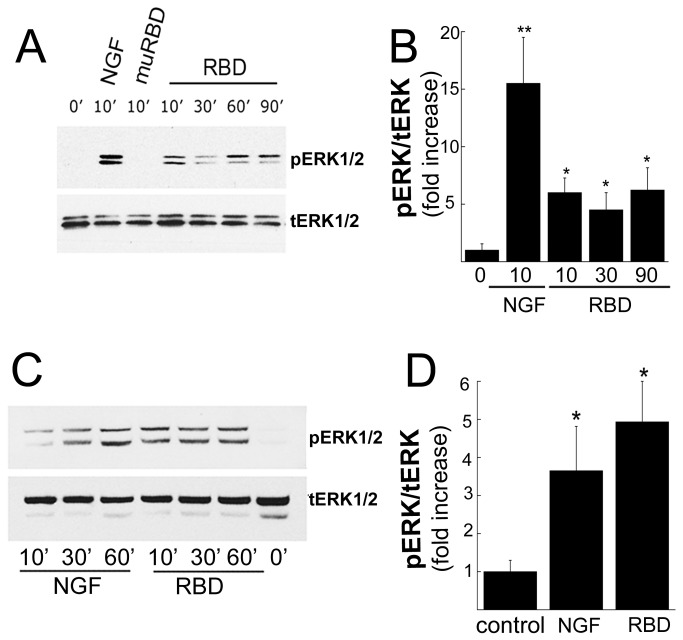
RBD induces LRP1-dependent and sustained ERK1/2 signaling in sensory neurons.
A, Immunoblot analysis of ERK1/2 after treatment with RBD, muRBD, NGF or vehicle for 0-90 min in PC12 cells. B, Quantification of ERK1/2 by densitometry (n=3-6/group). Total ERK1/2 was used as a loading control (**p<0.01; *p<0.05). C, Immunoblot analysis of ERK1/2 after RBD, NGF or vehicle treatment for 0-60 min in primary embryonic sensory neurons. D, Quantification of ERK1/2 by densitometry (n=4/group). Total ERK1/2 was used as a loading control (**p<0.01; *p<0.05). Equal amounts of cellular protein (50 µg) were loaded into each lane and subjected to SDS-PAGE and electrotransferred to nitrocellulose for detection with specific antibodies. Primary cultures of DRG neurons were prepared from rat embryos day 15 (E15).